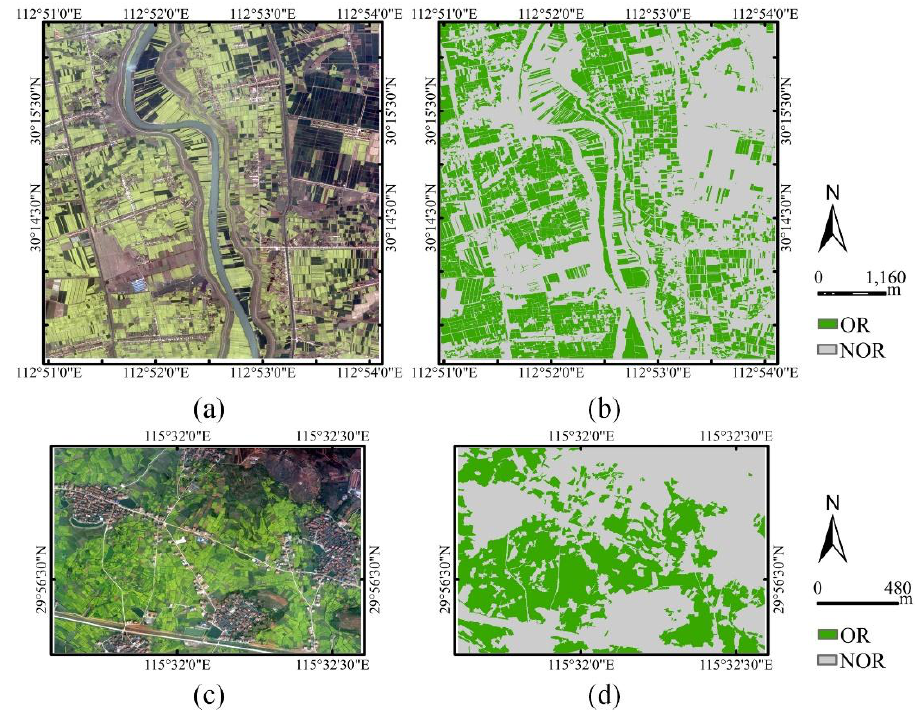
Figure 2. Local ( a ) Google Earth image of part of Qianjiang City on 25 March 2015; ( b ) oilseed rape map corresponding to ( a ); ( c ) Google Earth image of part of Wuxue City on 19 March 2016; and ( d ) oilseed rape map corresponding to ( c ). The NOR in the legend is the abbreviation for non-oilseed rape.